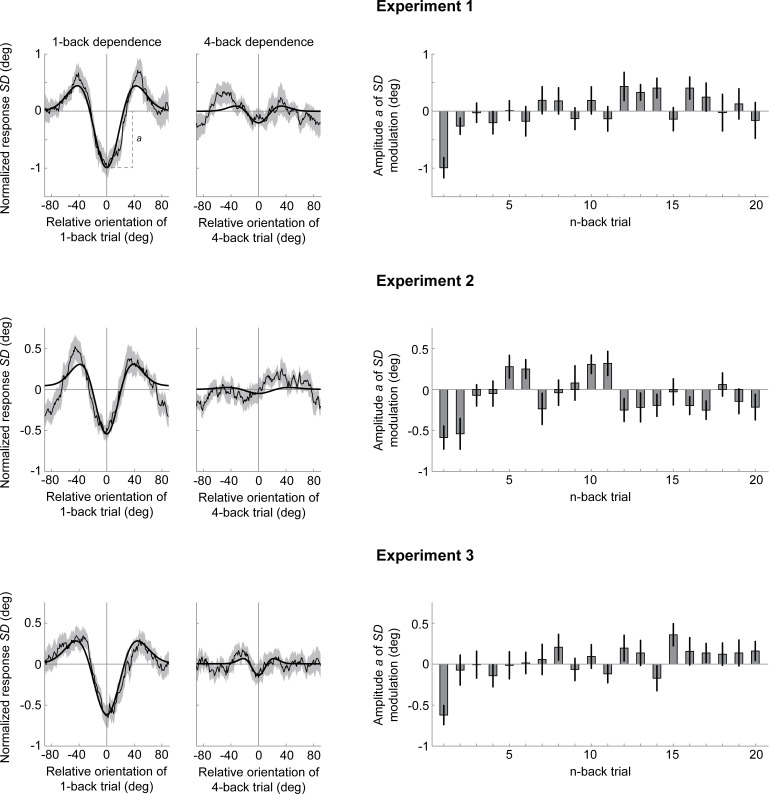
Normalized variability of estimation response errors as a function of the orientation difference between current and n-back trial.Variability of estimation response errors was quantified by computing each participant’s standard deviation of estimation response errors in a 30° sliding window over relative orientation differences between current and n-back trial. The resulting conditional response variability estimates were normalized by subtracting each participant’s mean response variability before averaging across participants. Across all three estimation experiments, there was a clear reduction in response variability when current and previous stimuli had similar orientations (left column, thin black line) and this pattern was well captured by a second-derivative-of-a-gaussian curve (bold black line). The amplitude parameter a of the gaussian derivative model quantifies the reduction of response variability at 0° relative orientation difference. While for some n-back trials there appears to be a small reduction in response variability (e.g. 4-back trials, middle column), temporally more distant trials show no consistent effect overall (right column). Shaded error regions around the group-averaged example curves depict SEMs. Error bars on amplitude estimates depict 1 SD of the bootstrapped amplitude distribution, resampling participants with replacement.